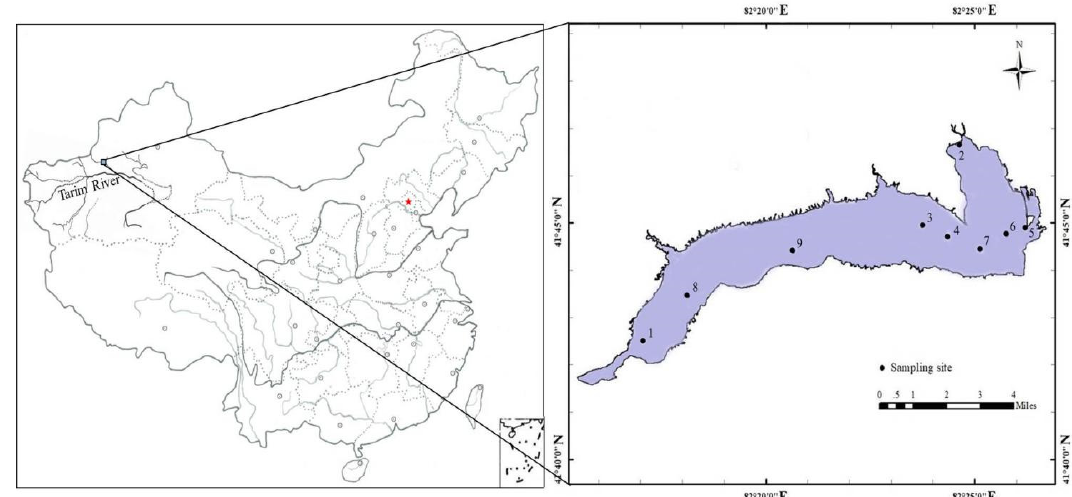
Figure 1. Locations of sampling sites in the Kizil Reservoir.